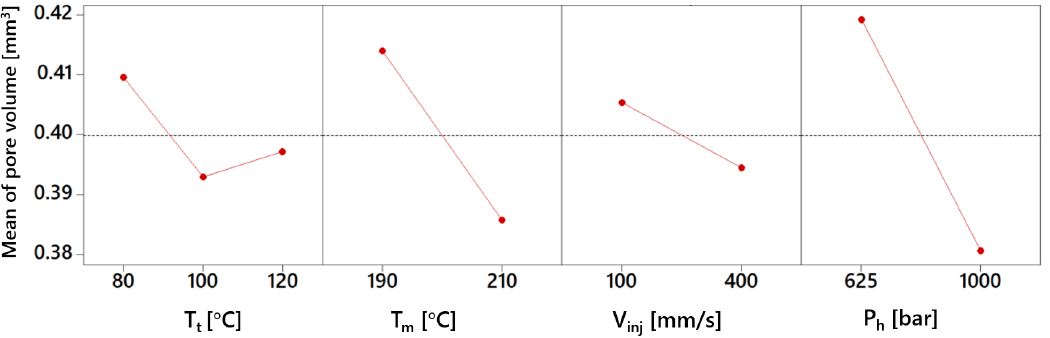
Figure 7. Main effect plots for pore volume (the dashed lines show the total